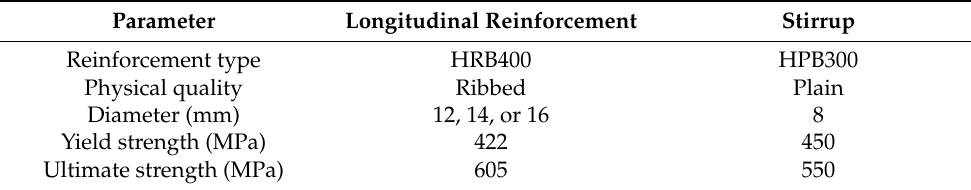
Figure 8. The main process of the F – T segments. ( a ) Details of a segment. ( b ) Preparation before pouring. ( c ) Pouring concrete of segment. Table 5. The mixed proportions of concrete (kg/m 3 ).